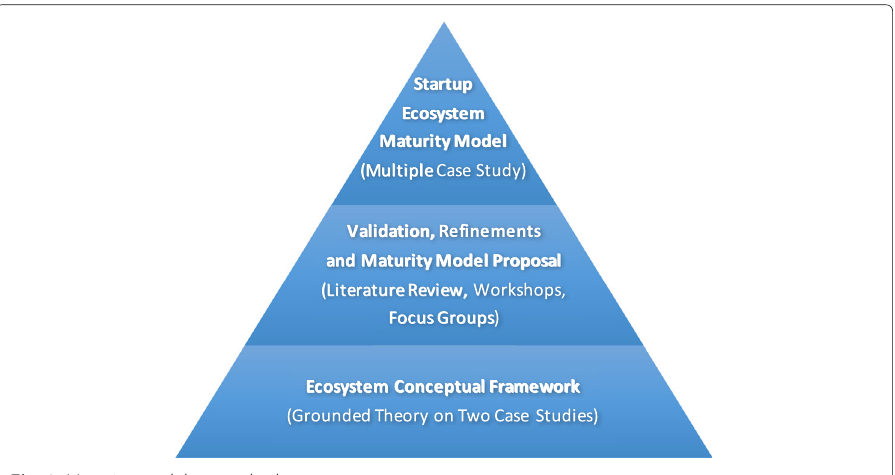
Fig. 2 Maturity model research